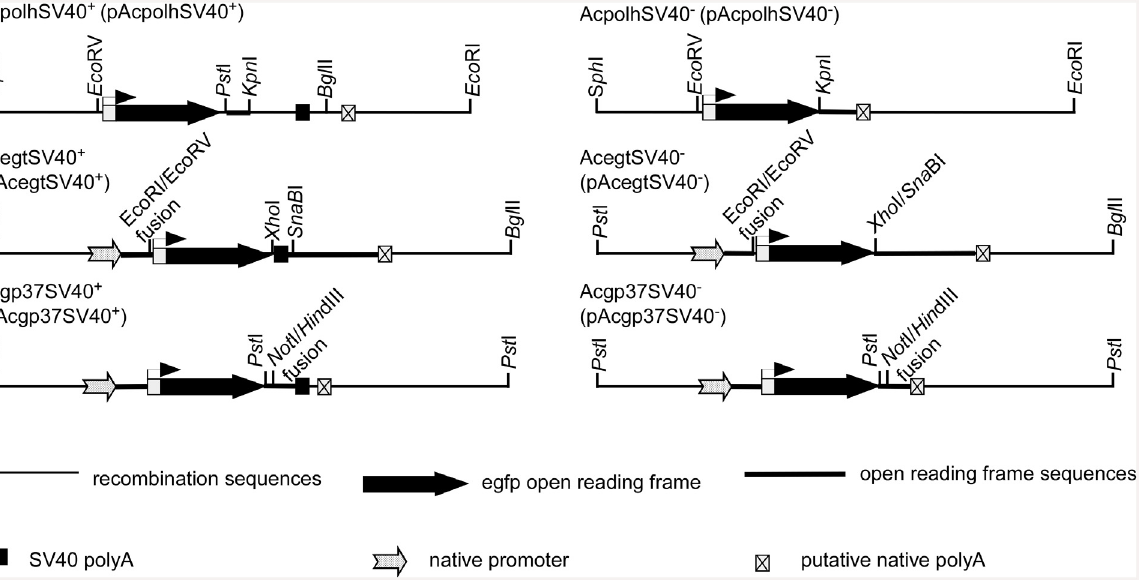
Fig 1. Schematic diagram of viral constructs with and without SV40 polyA signals for egfp gene expression under the AcMNPV polh promoter control at the polh , egt and gp37 loci of AcMNPV genome to test the functions of SV40 polyA in the baculovirus expression vector system. The putative polyA signal in Acgp37SV40+ and Acgp37SV40- is a prediction but not verified since no 3 ’ RACE products were